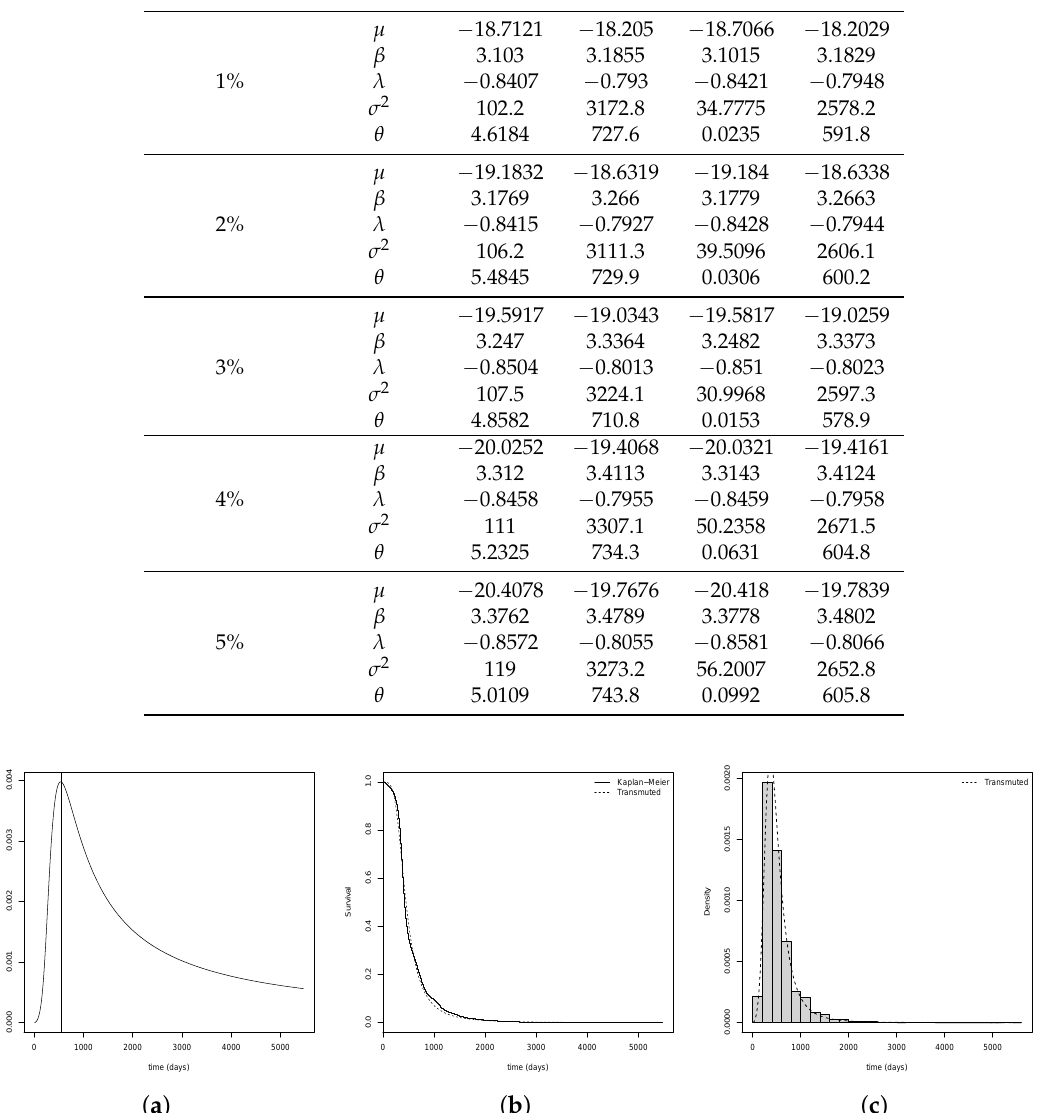
Figure 7. ( a ) Hazard estimate curve, with the ˆ T max , ( b ) survival curves and ( c )